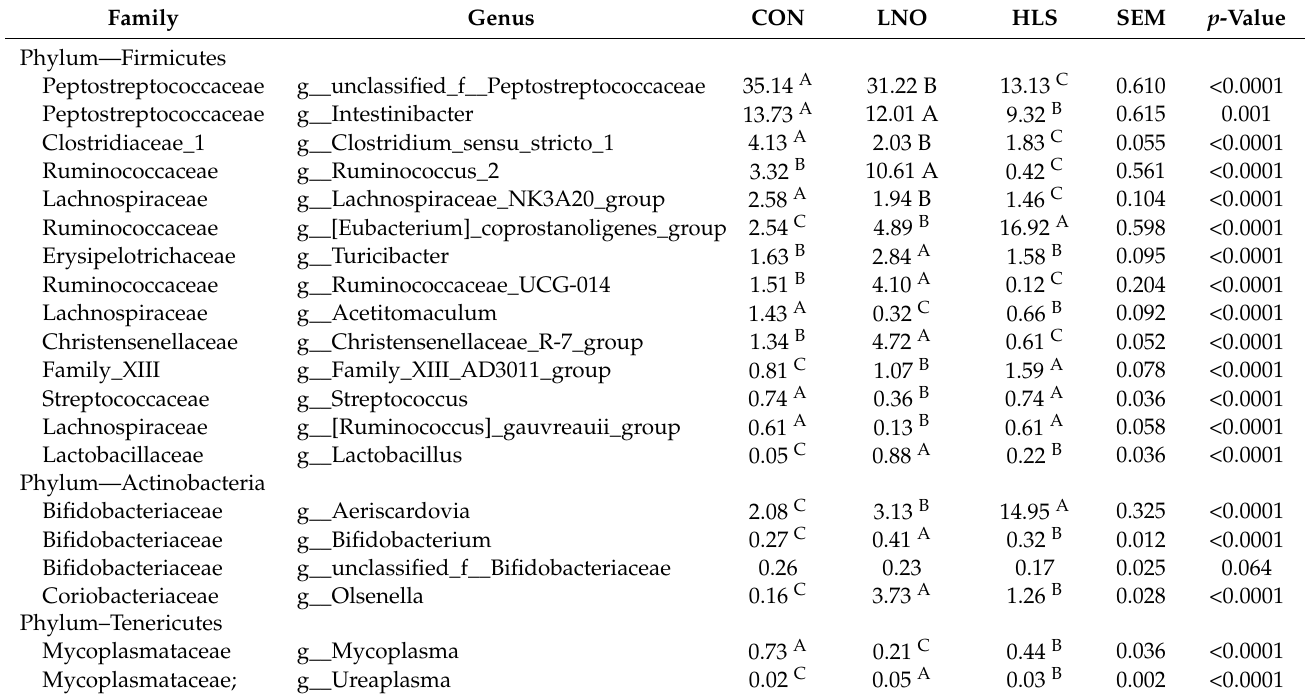
Table 9. The effect of dietary flaxseed oil or heated flaxseed supplementation on the relative abundance of the top 20 bacteria in ileum digesta—Genus level